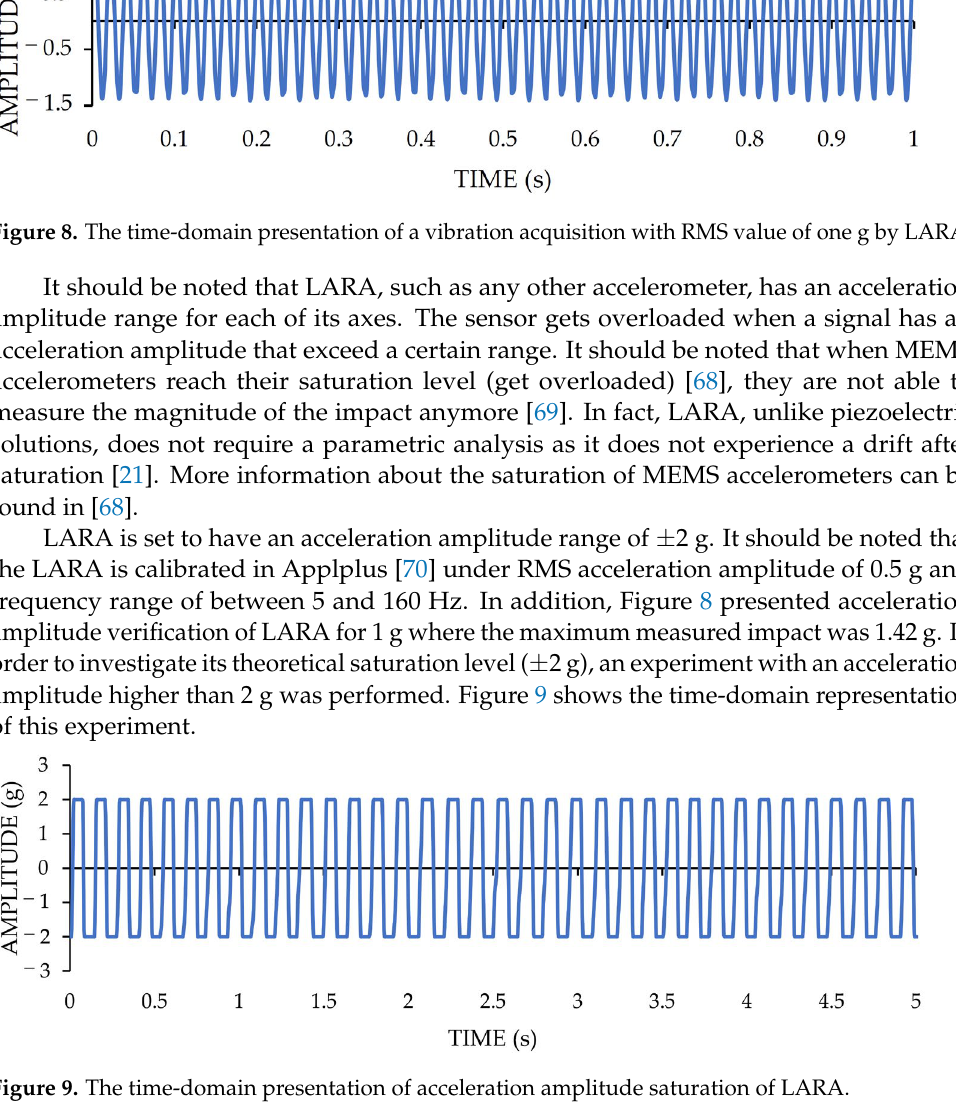
Figure 9. The time-domain presentation of acceleration amplitude saturation of LARA.